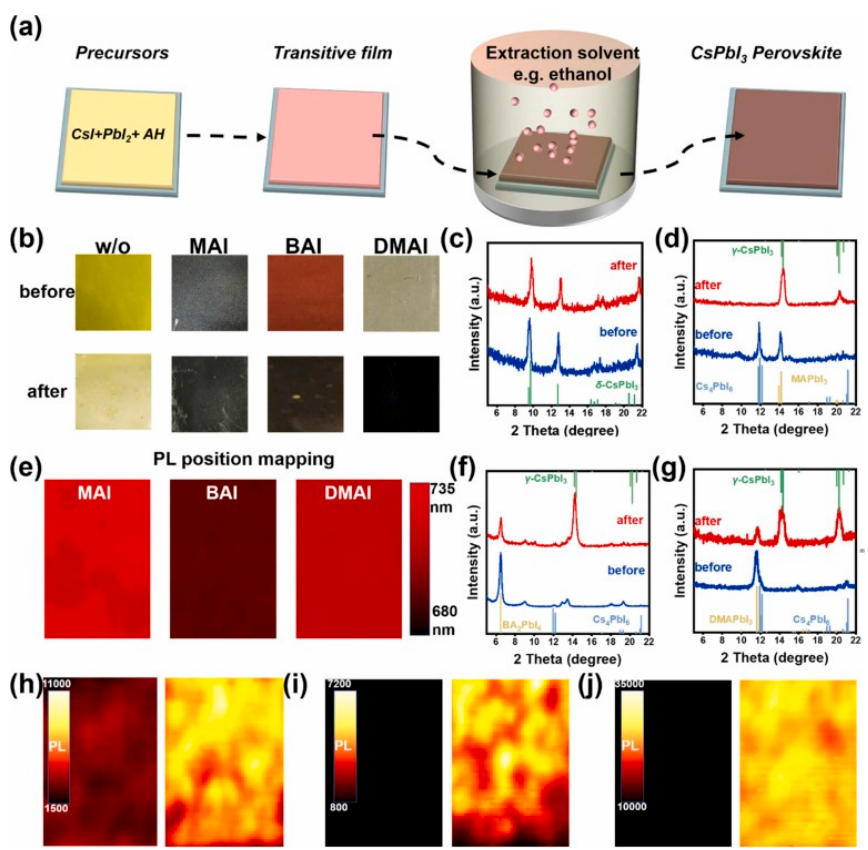
Figure 2. EAH-S method to grow CsPbI 3 perovskite. ( a ) Schematic diagram of EAH-S method. AH: ammonium halide. ( b ) Photographs of the transitive films prepared from the precursor solutions with/without ammonium iodides and the corresponding films after soaking in EtOH. XRD patterns of the transitive films and the corresponding films after soaking in EtOH: ( c ) without ammonium iodides, ( d ) MAI, ( f ) BAI ,and ( g ) DMAI. ( e ) PL position mapping of the transitive films after soaking in EtOH. PL intensity mapping of the transitive films and the corresponding films after soaking in EtOH: ( h ) MAI, ( i ) BAI, and ( j ) DMAI reprinted with permission from Ref. [112] 2022 Elsevier. Table 2. Summary of various inorganic PSCs’ performance using solvent engineering. Device Configuration